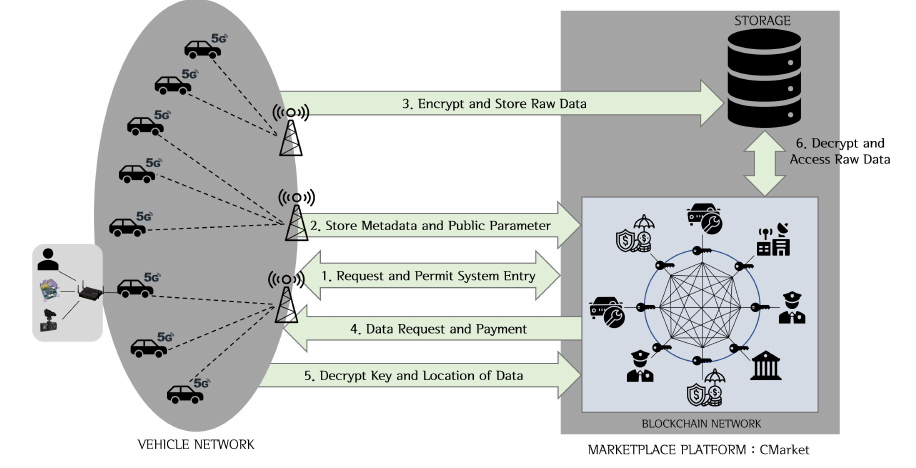
Figure 3. Marketplace Platform: CMarket and Data